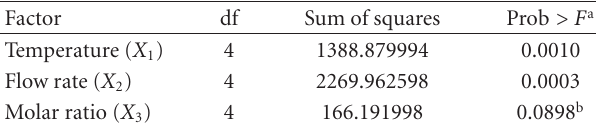
Table 3: Analysis of variance for the joint